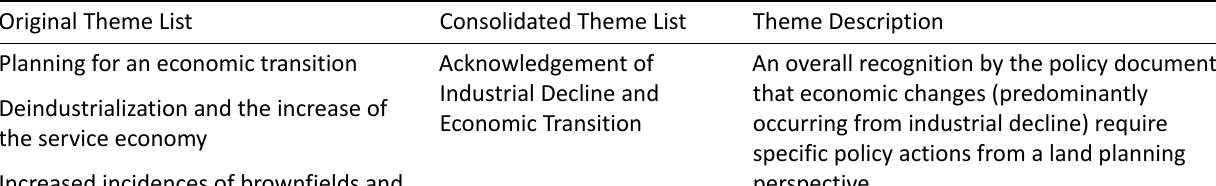
Table 1. Summary of theme consolidation